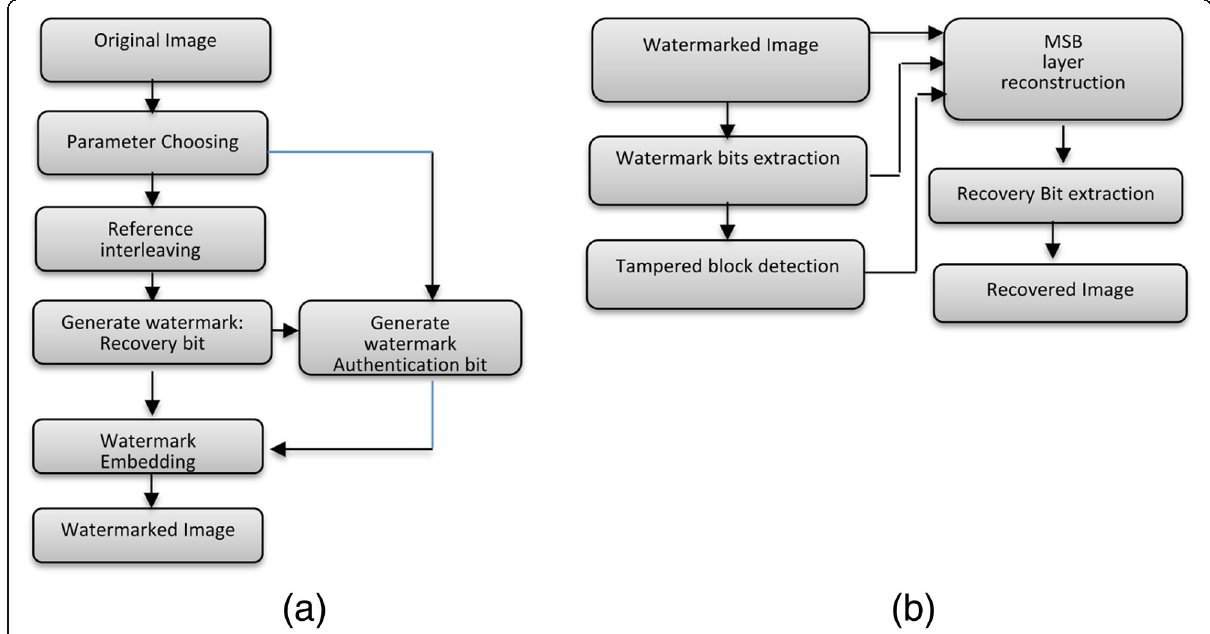
Fig. 16 Block diagram of ( a ) watermark embedding and ( b ) extraction process for Qin et al. ’ s method